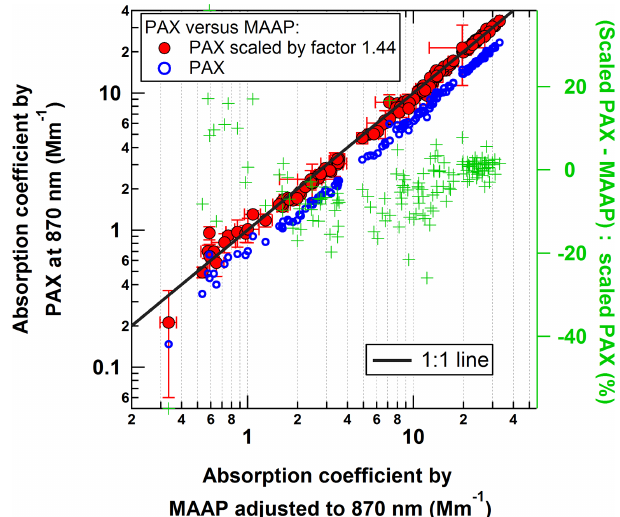
Figure 2. Comparison of the absorption coefficients measured by the PAX and the MAAP. The MAAP data measured at 637nm were adjusted to 870nm using the spectral dependence of the absorption measured by the aethalometer. The PAX data measured at 870nm are shown with the original calibration and after scaling by a factor 1.44 to match the MAAP data on average. The percentage differ- ence between the scaled PAX and MAAP measurements is plotted on the right-hand y axis (green